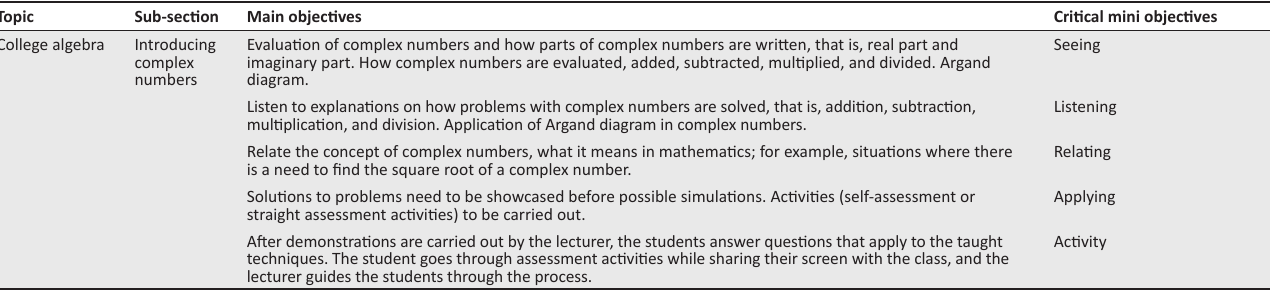
TABLE 2: Lesson plan for an ERT in an